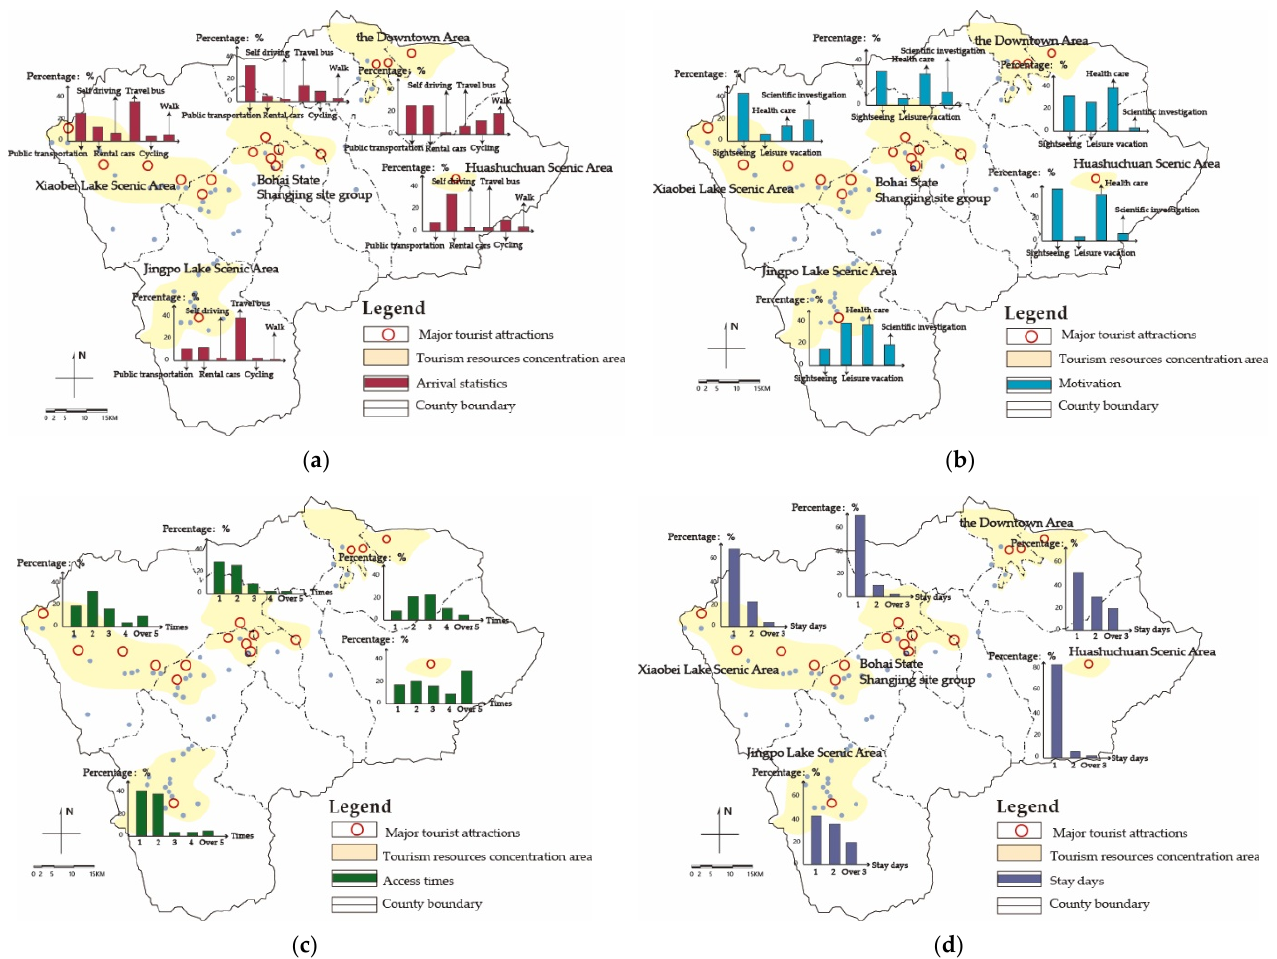
Figure 5. Investigation of tourism resources: ( a ) arrival mode, ( b ) motivation, ( c ) access times, and ( d ) stay